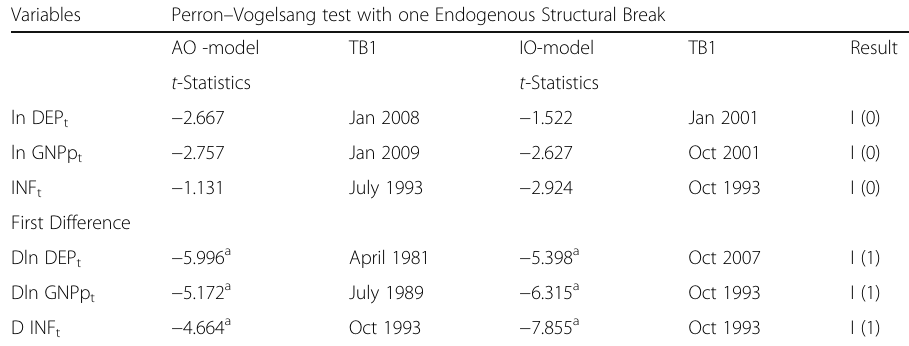
Table 2 Perron – Vogelsang test with one Endogenous Structural Break